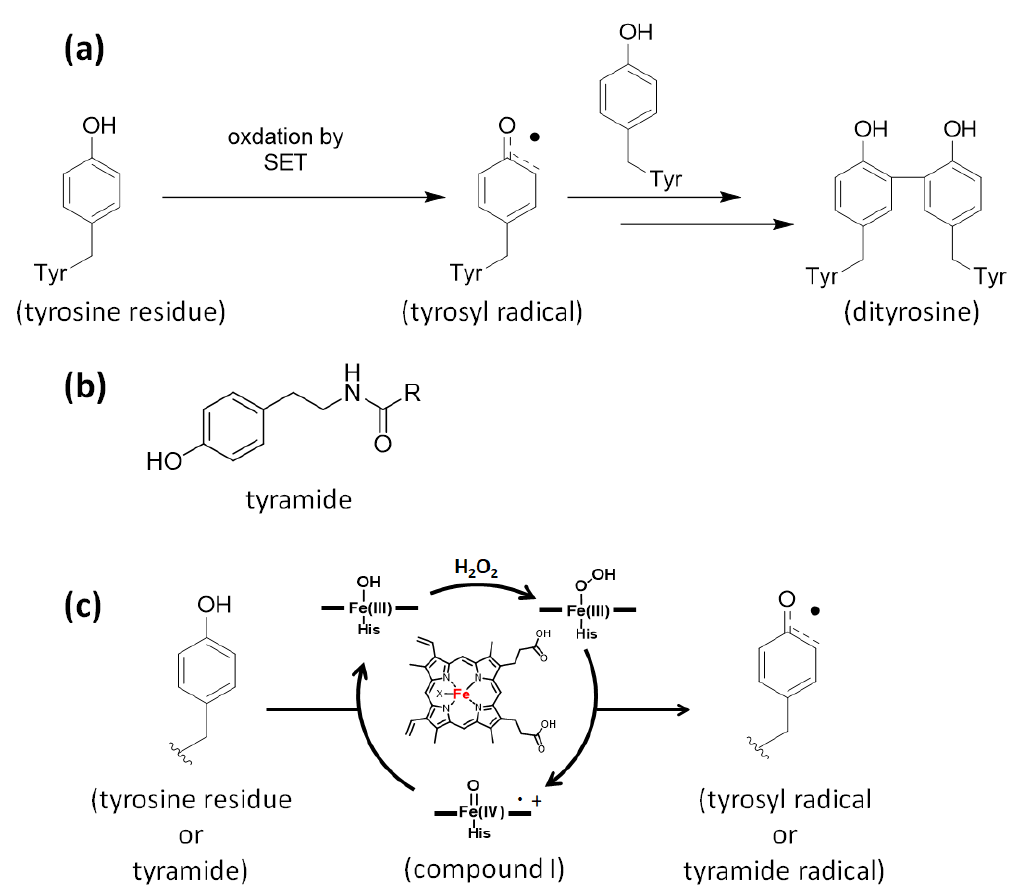
Figure 1. Generation of tyrosyl radical and tyramide radical. ( a ) Mechanism of dityrosine generation via single-electron transfer (SET). ( b ) Tyramide, a labeling agent that mimics tyrosine ( c ) Mechanism of oxidation in the active site of horseradish peroxidase (HRP).